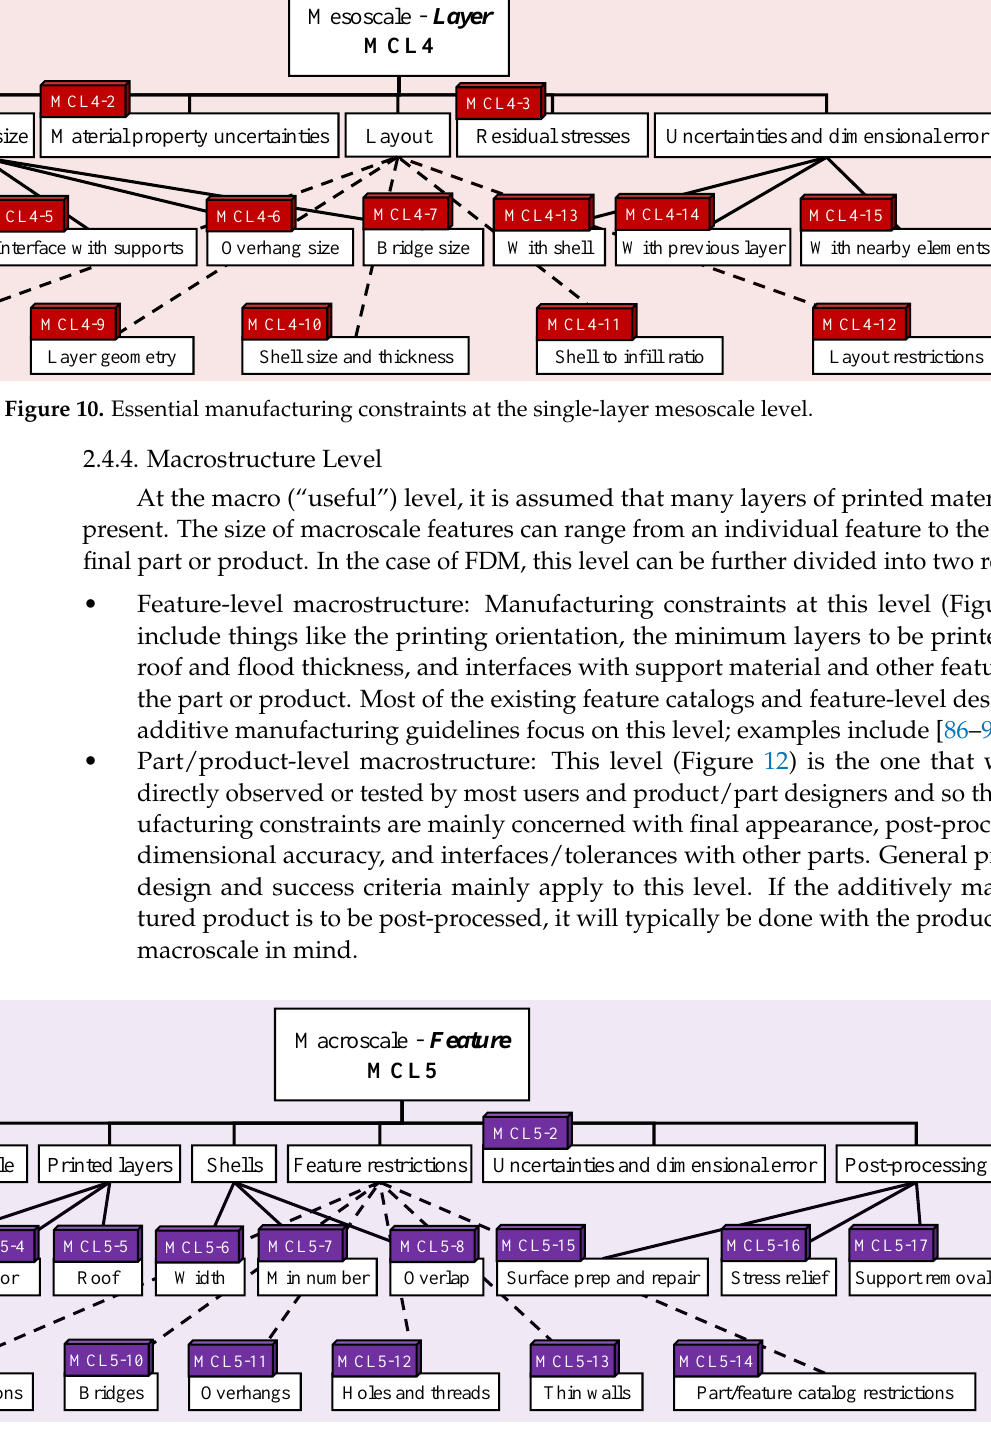
Figure 11. Essential manufacturing constraints at the macroscale (feature)